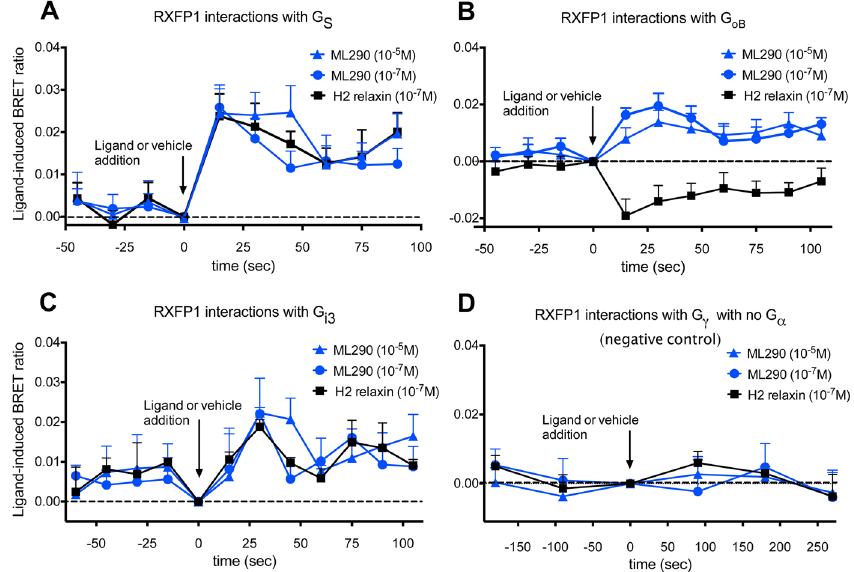
Figure 2. RXFP1 - G protein interactions and treatment with H2 relaxin or ML290. HEK-RXFP1-Rluc8 cells were transiently co-transfected with G γ 2-Venus, G β 1 and one of G α subunits (G α s , G α oB , G α i3 ). Interactions between RXFP1 and G proteins were detected prior to and after treatment with H2 relaxin (0.1 μ M) or ML290 (0.1 μ M or 10 μ M) using real-time BRET assays. Both ML290 and H2 relaxin induced interactions between RXFP1-Rluc8 and G α s , G α oB , and to a lesser extent G α i3 ( A – C ). Shifts in BRET ratio between RXFP1 and G α s were quantitatively and qualitatively similar with ML290 and H2 relaxin. However the ML290 RXFP1- G α oB ligand-induced BRET ratio moved in the opposite direction to that to H2 relaxin ( B ) suggesting that each ligand induces a different receptor conformation. Interactions between RXFP1 and G α i3 with H2 relaxin and ML290 were weak but qualitatively similar. There were no interactions between RXFP1-Rluc8 and G γ 2-Venus in the absence of G α subunits ( D ). Ligand-induced BRET ratios were calculated by subtracting the BRET ratio for the vehicle-treated sample from that obtained from each ligand-treated sample as described in Materials and Methods. Data are mean ± SEM of 4 independent